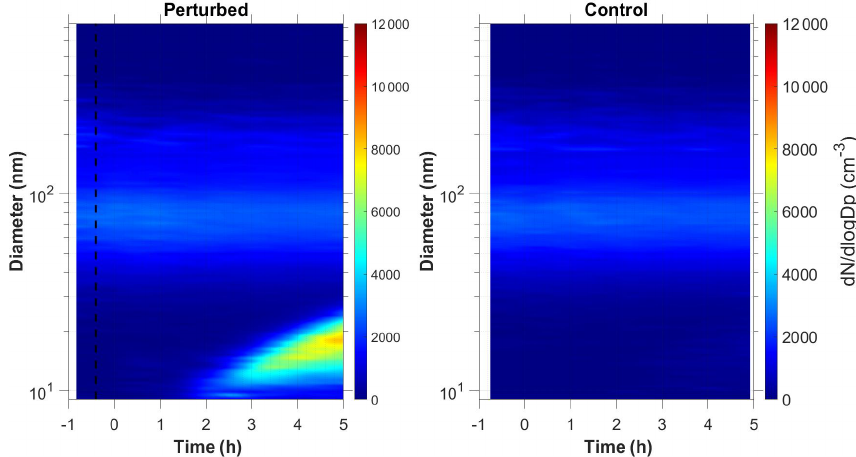
Figure 2. Wall loss corrected measured number distributions in the two chambers for Exp. A1.